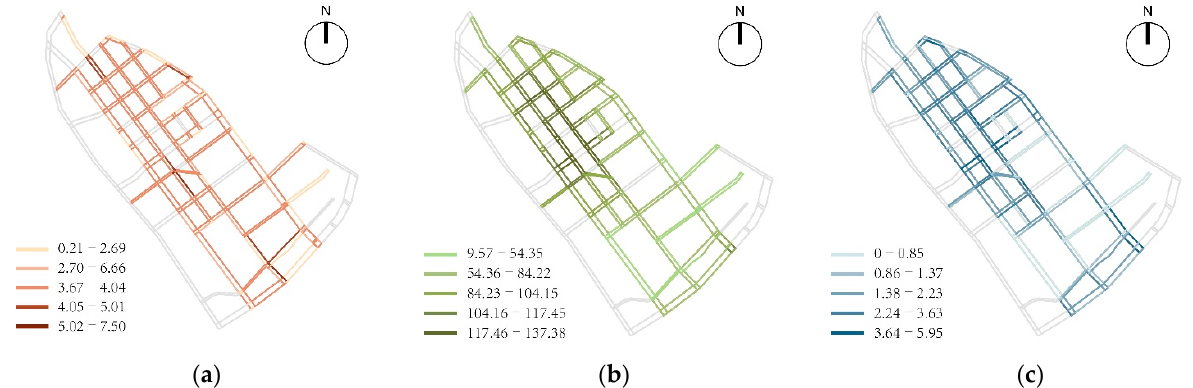
Figure 9. The analysis of pedestrian network accessibility: ( a ) Angular Connectivity; ( b ) Integration R600 metric; ( c ) Choice R600 metric.